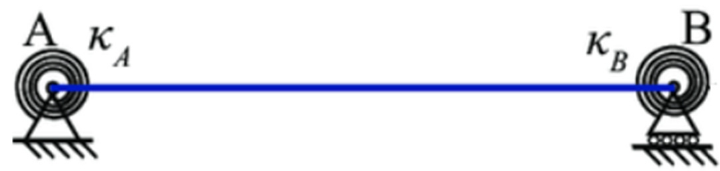
Figure 8. Simplified model that accounts for the rigidity of transverse stiffeners.